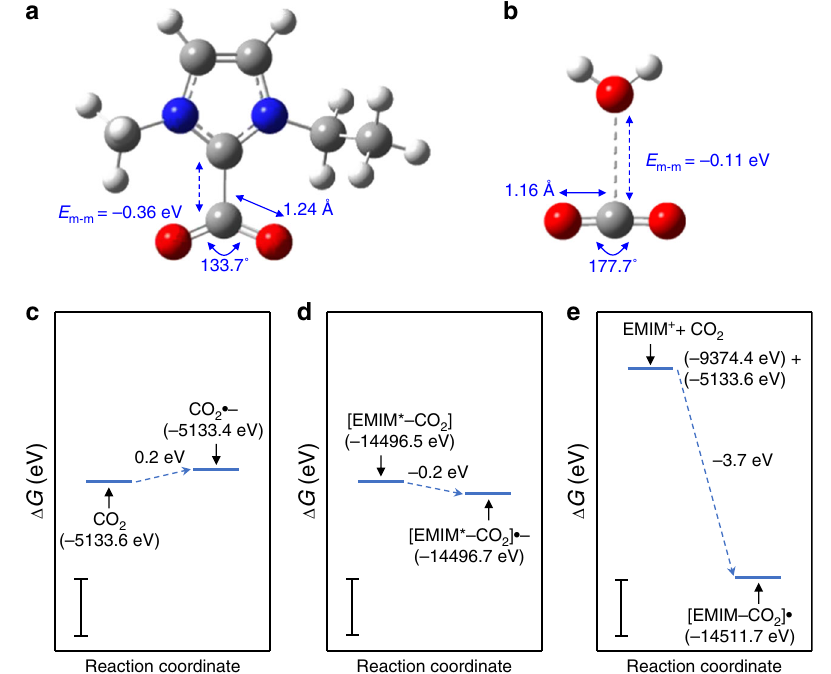
Fig. 3 The role of the ionic liquid in Au NP-photocatalyzed CO 2 RR. a , b DFT-optimized geometries of [EMIM*-CO 2 ] ( a ) and [H 2 O-CO 2 ] ( b ) complexes. C, H, O, and N atoms are depicted by gray, white, red, and blue spheres, respectively. Key bond lengths, bond angles, and the energy of intermolecular interaction, E m-m , are indicated for each of the complexes. c – e DFT-computed free energy cost, Δ G , of formation of the 1e − adduct of CO 2 ( c ), 1e − adduct of [EMIM*-CO 2 ] ( d ), and 1e − adduct of CO 2 in the presence of EMIM + ( e ). In the latter case, the 1e − adduct of CO 2 , CO 2 (cid:129) − , is stabilized by complexation with EMIM + as described by the net process: EMIM + + CO 2 + e − → [EMIM-CO 2 ] (cid:129) . In c – e , the free energy of each species is indicated in parentheses. Scale bars are 1 eV in